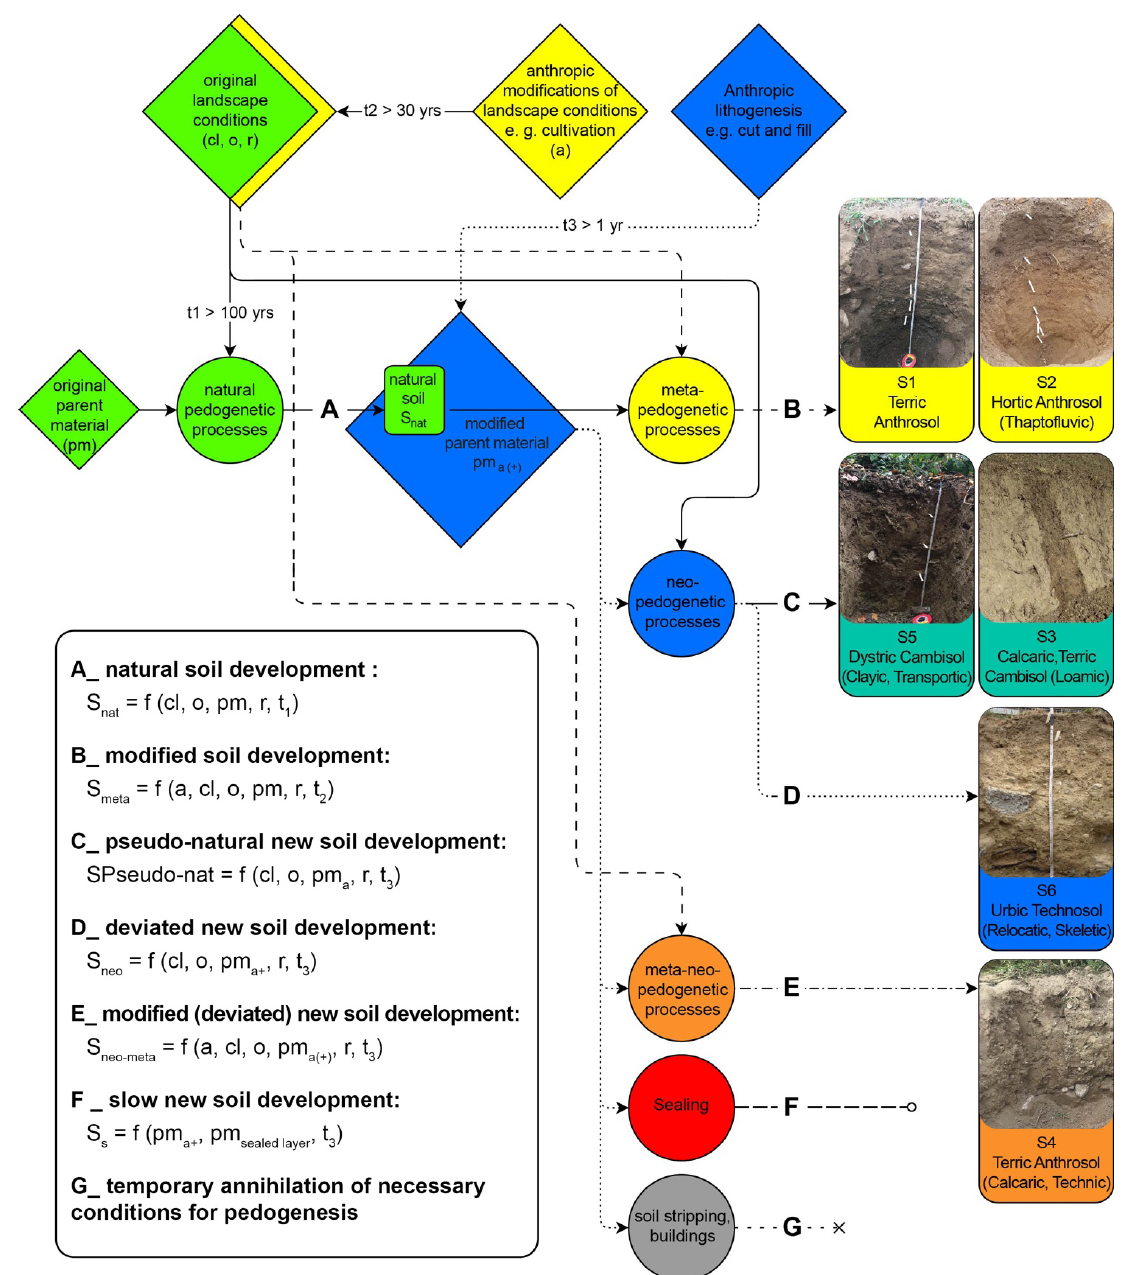
Figure 2. Causal chain conceptual model of anthropedogenesis. Source: Authors, after Yaalon and Yaron (1966), Effland and Pouyat (1997), and Yaalon and de Richter (2011), with photos from UNINE–UNIL Biogeoscience Master’s Degree, Fall